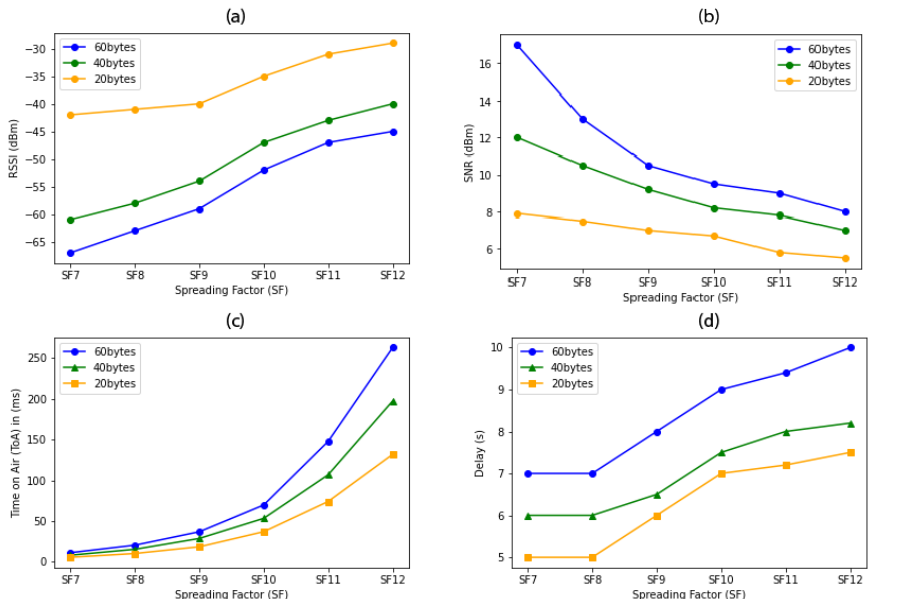
Figure 20. LoRaWAN behavior ( a ) RSSI, ( b ) SNR, ( c ) ToA and ( d ) Delay of packets sent by EEC